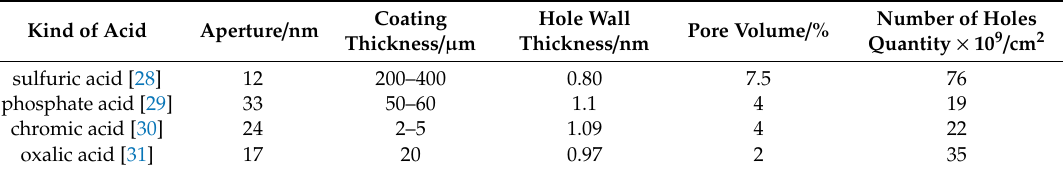
Figure 1. Crystalline phase transformation mechanism of pre-anodic coating. Table 2. Micro-structure parameters of aluminum alloy anodic coatings in different electrolyte.